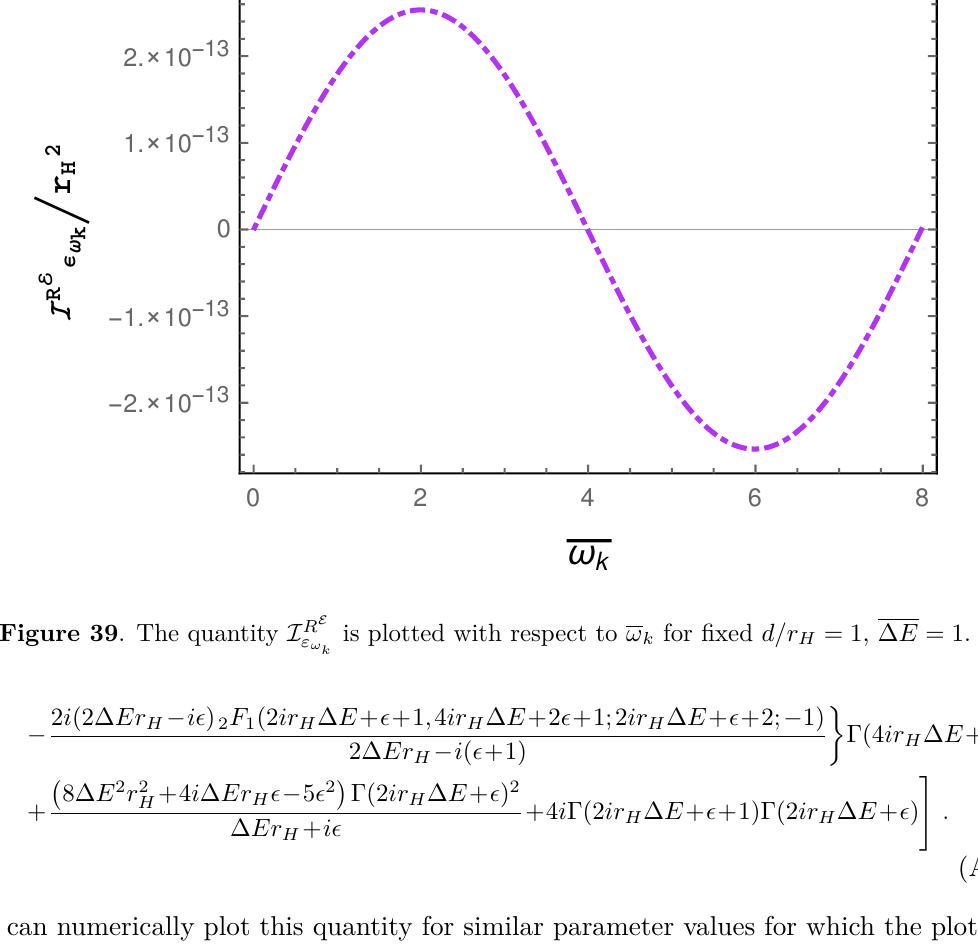
for fixed d/r = 1 , ∆ E = 1 k H